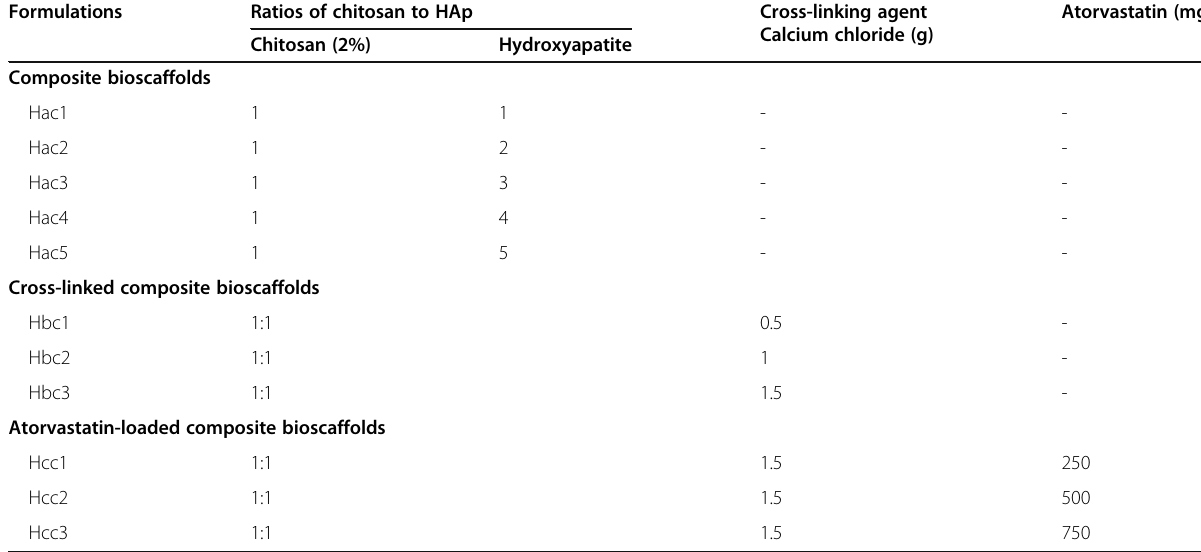
Table 1 Composition of prepared different composite bioscaffolds Formulations Ratios of chitosan to HAp